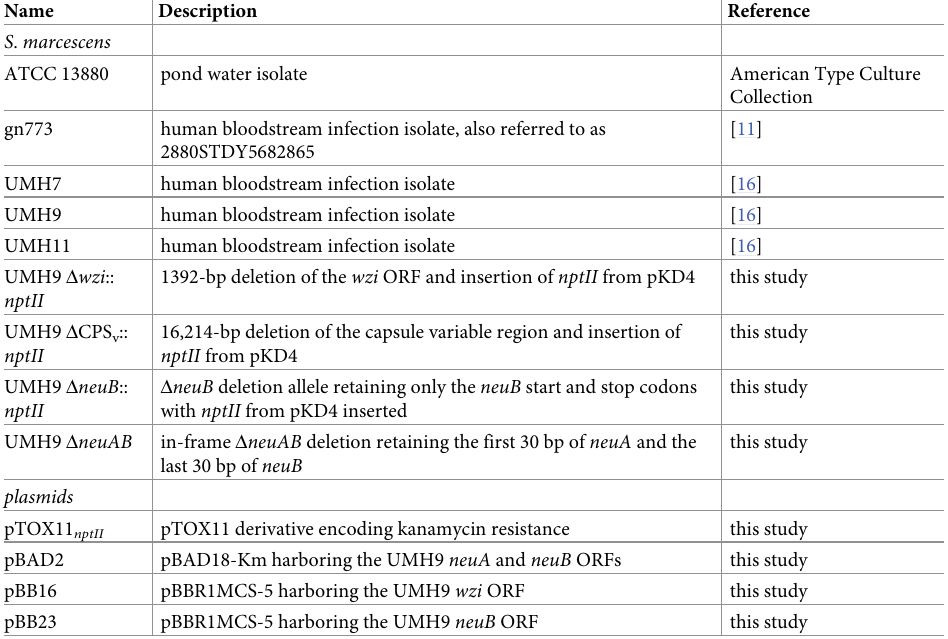
Table 1. S . marcescens strains and recombinant plasmids used in this